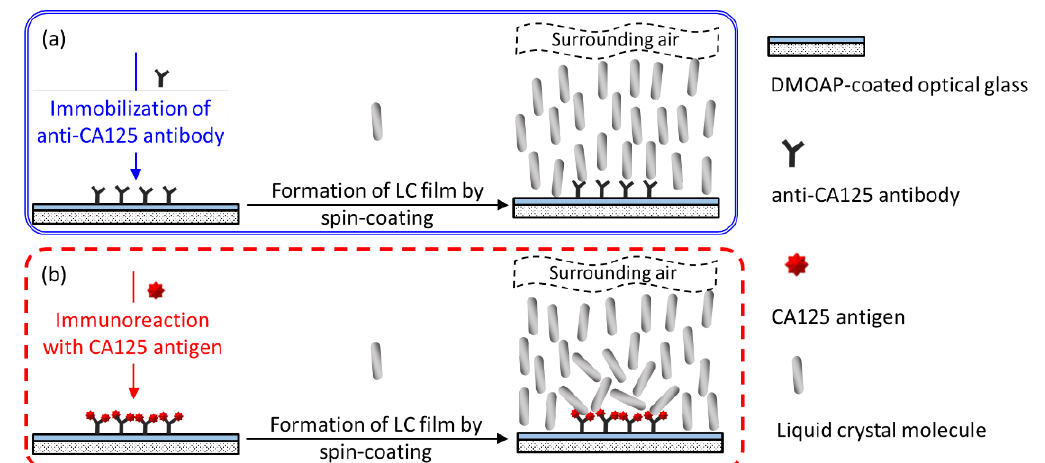
Figure 6. Schematics of the working principle of the LC-based single-substrate immunoassay for the detection of CA125 with spin-coated LC film on a DMOAP-coated substrate. ( a ) In the absence of CA125, LC molecules are aligned homeotropically on immobilized anti-CA125 antibody, whose amount is adjusted to a maximum without disturbing the orientation of LCs. ( b ) In the presence of CA125, alignment of LC molecules is disrupted due to the formation of the CA125 immunocomplex atop the DMOAP aligning layer.